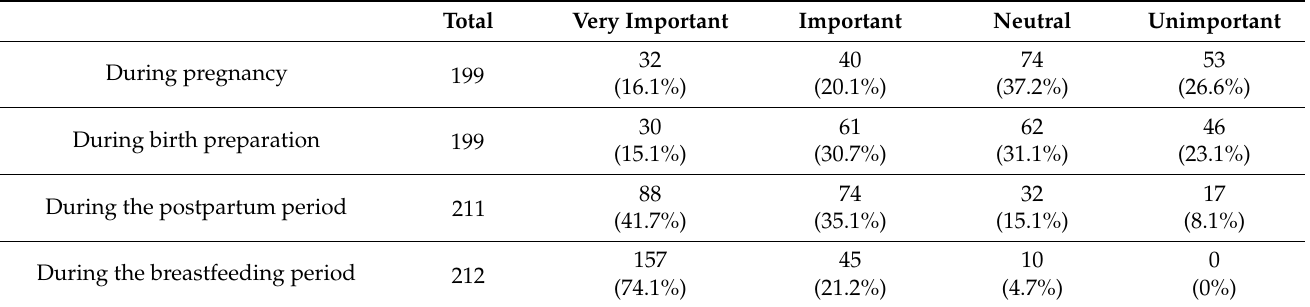
Table 4. Results regarding when the right time would be to educate parents about the FUs in absolute values and in percentages